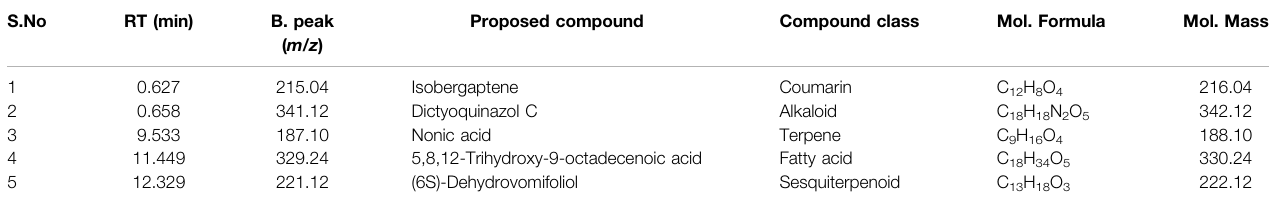
TABLE 3 | UHPLC-MS analysis of the ethanolic extract of C. gigantea leaves (negative ionization mode). S.No RT